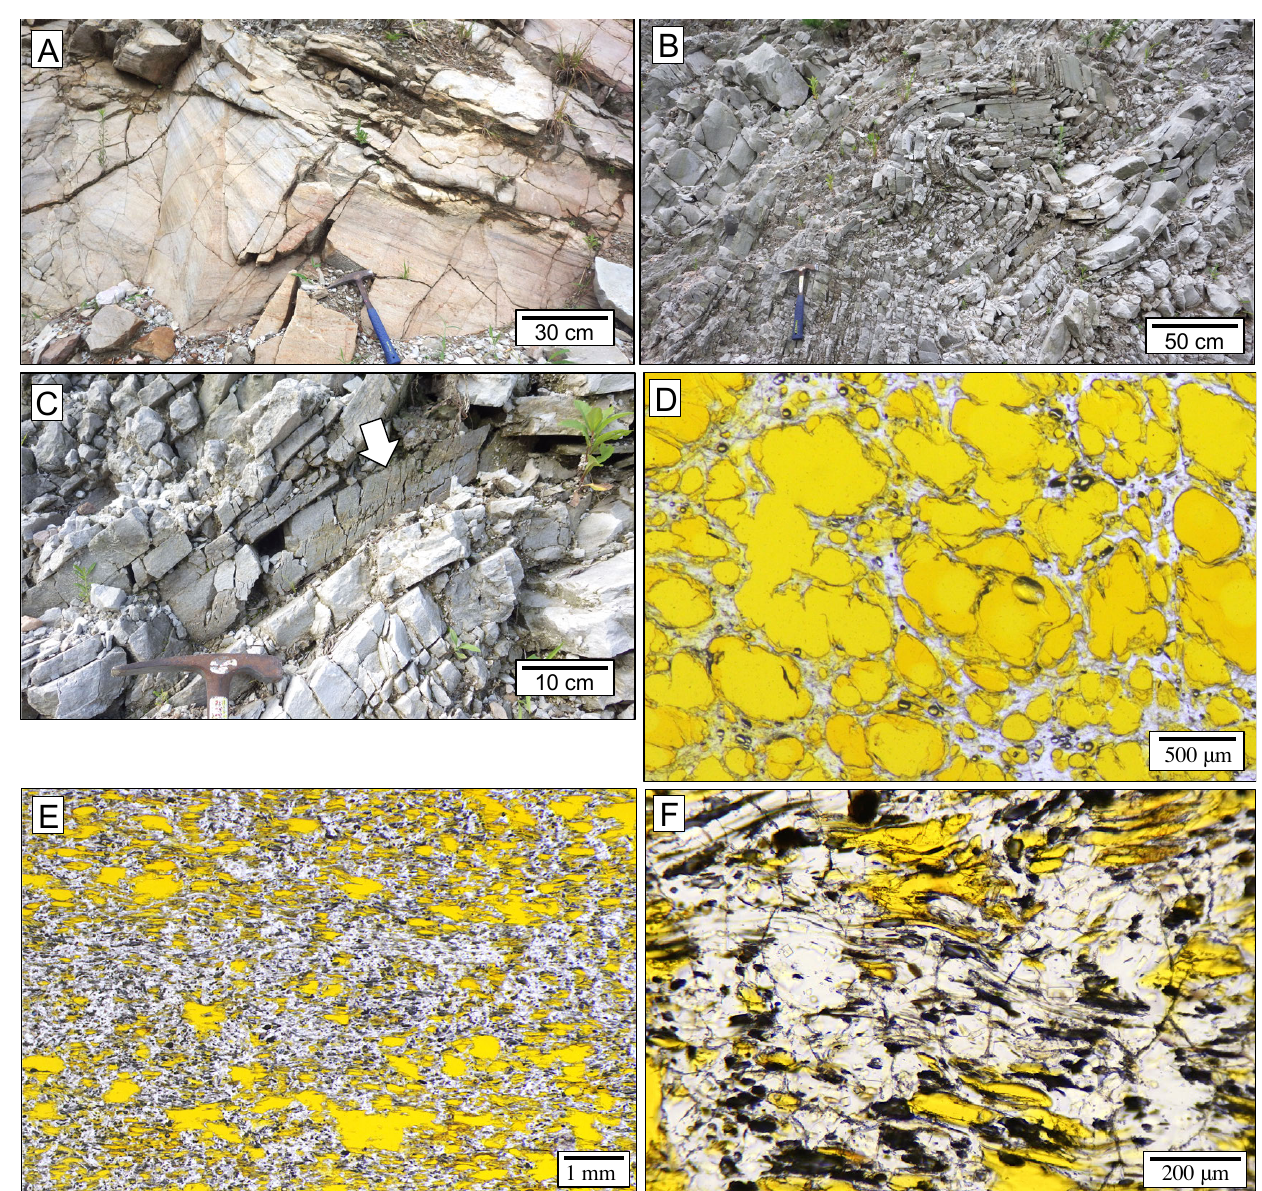
Figure 13: [A] Vesicular lithofacies of Shiroyama lava in the quarry. Flow banding is conspicuous. [B] Platy joints and their buckle folding in the lava margin. [C] En echelon cracks developed in the lava margin. [D] Plane-polarized photomicrograph showing the bubbles (yellow area) of the vesicular lithofacies in the northernmost part of the quarry. Note their spherical shape and interconnection. [E] Plane-polarized photomicrograph showing the bubbles of the vesicular lithofacies in the central part of the quarry. [F] Bubbles are highly elongated and